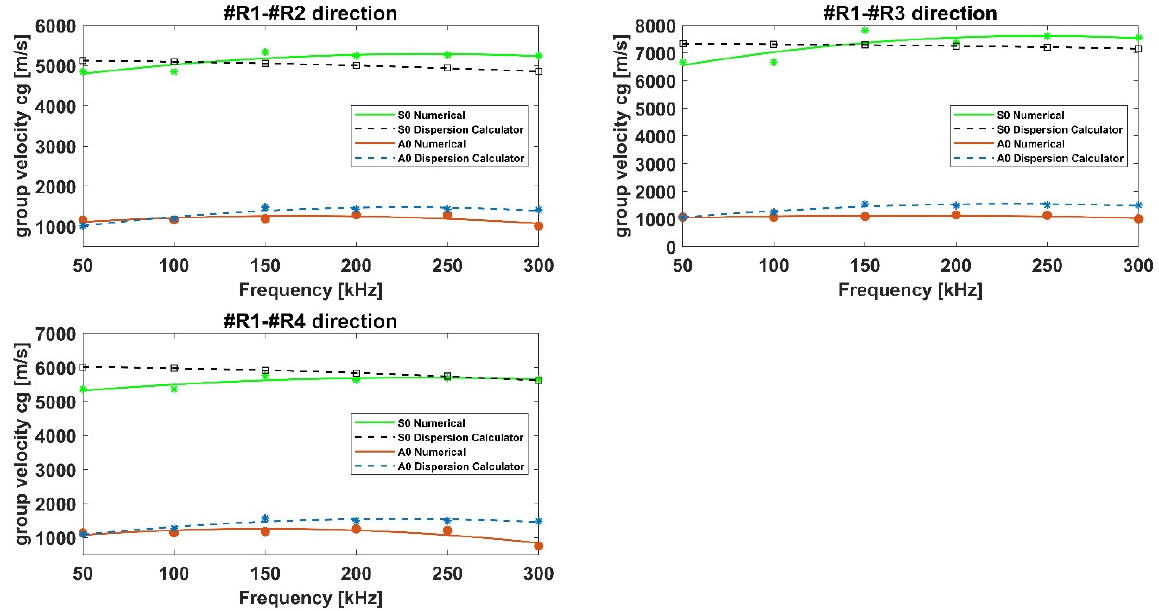
Figure 5 . Dispersion curves for the flat composite panel. Figure 5. Dispersion curves for the flat composite